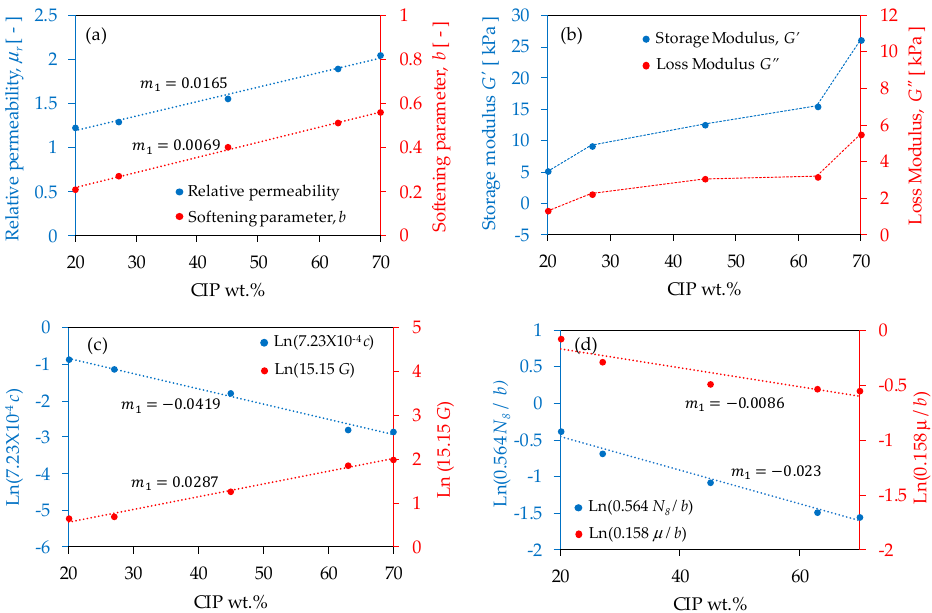
Figure 21. Magneto-mechanical charts for a constant magnetic flux density of 52.2 mT. ( a ) Linear relationship of the relative permeability and of the stress softening parameter versus the wt % of CIPs concentration. ( b ) Storage and loss moduli curves obtained from rheological measurements versus the iron particles concentration. ( c ) Semi-log curves of the residual strain parameter and the material shear modulus versus wt % of CIPs. Notice that both curves exhibit a constant slope that is an indication of the exponential material behavior when subjected to a magnetic field. ( d ) This figure illustrates the ratio of the N 8 / b , and µ / b plotted versus the wt % of CIPs. These curves indicate their exponential relationship with respect to the carbonyl iron particles concentration.